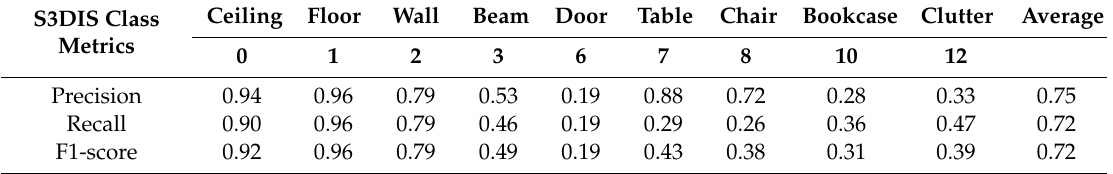
Table 11. Per class metrics for the full S3DIS dataset using our approach.